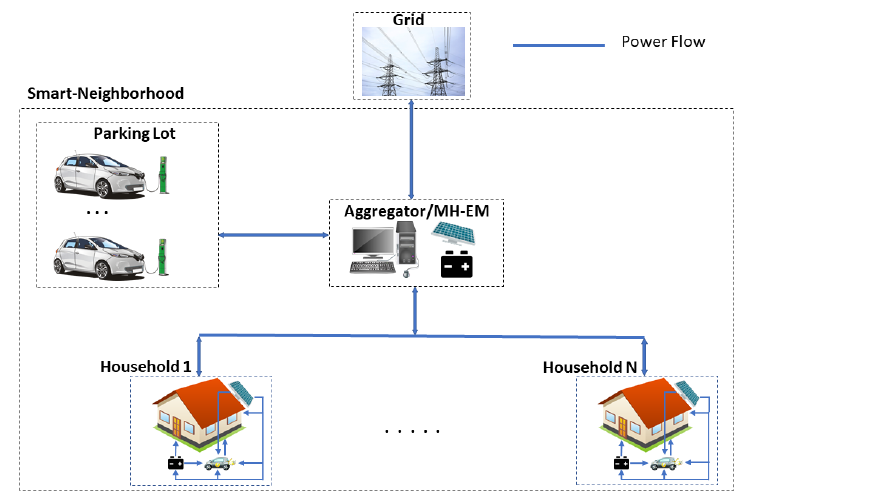
Figure 1. General topology of the Smart Neighborhood considered in this